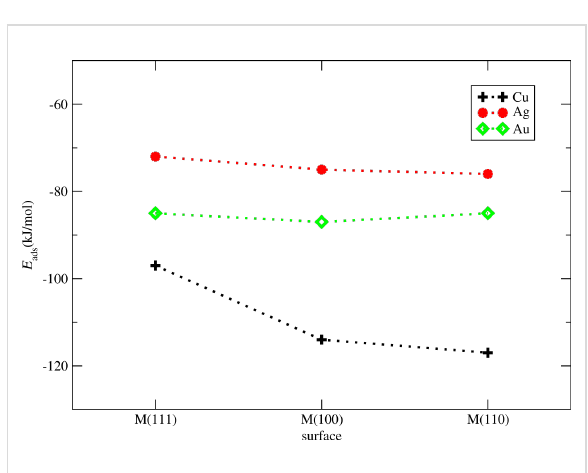
Figure 2: Benzene on Cu, Ag, and Au surfaces. Calculated adsorp- tion energies in kJ/mol for M(111), M(100), and M(110), M = Cu, Ag,